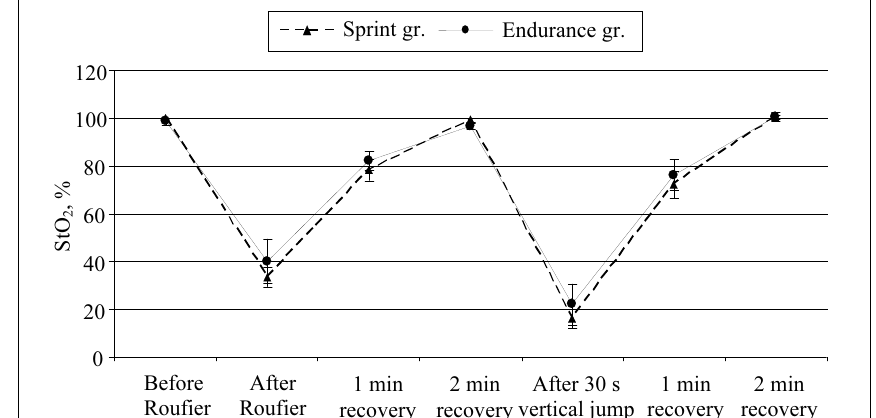
Figure 3. Dynamics of StO 2 during dosed and maximal exercise test